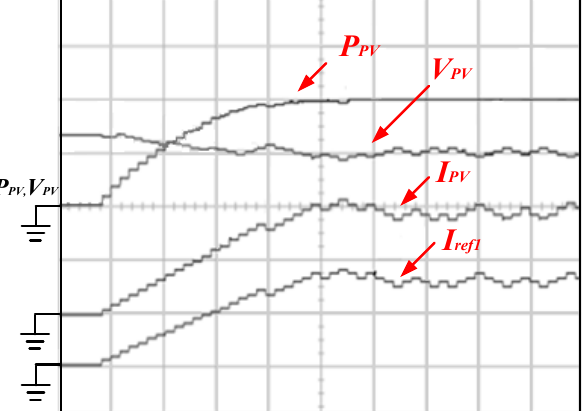
: 100 W/div, V : 200 V/div, I : 1 A/div, I : 1 V/div, time : 5 s/div). PV PV PV ref_1